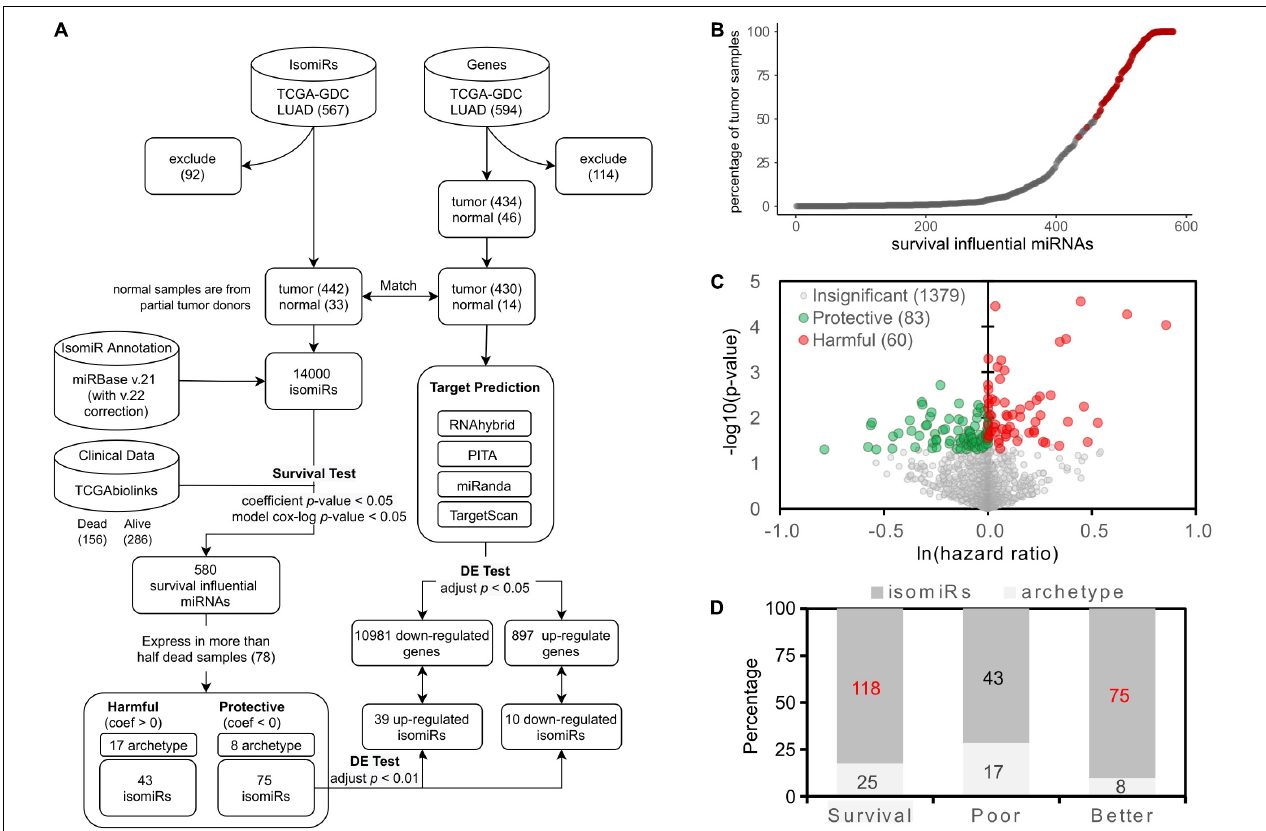
FIGURE 1 | Identification of the survival influential miRNAs. (A) The overall workflow of identifying the survival influential miRNAs. (B) Percentage of samples in which the survival influential miRNAs are expressed. The x -axis lists the miRNAs, which are significantly associated with patients’ prognoses, ordered by the number of samples in which they are expressed. The red dots are those survival influential miRNAs expressed in at least 50% of dead samples. (C) Volcano plot for survival influential miRNAs. The x -axis is the natural log of the hazard ratio of miRNAs; the y -axis shows the corresponding significance. The miRNAs with significant influence on patient prognosis are colored by green (protective) and red (harmful). (D) The prevalence of survival influential isomiRs. The survival category indicates all the survival influential miRNAs, i.e., contains poor and better prognoses. Numbers labeled red indicate a significantly overrepresented proportion of